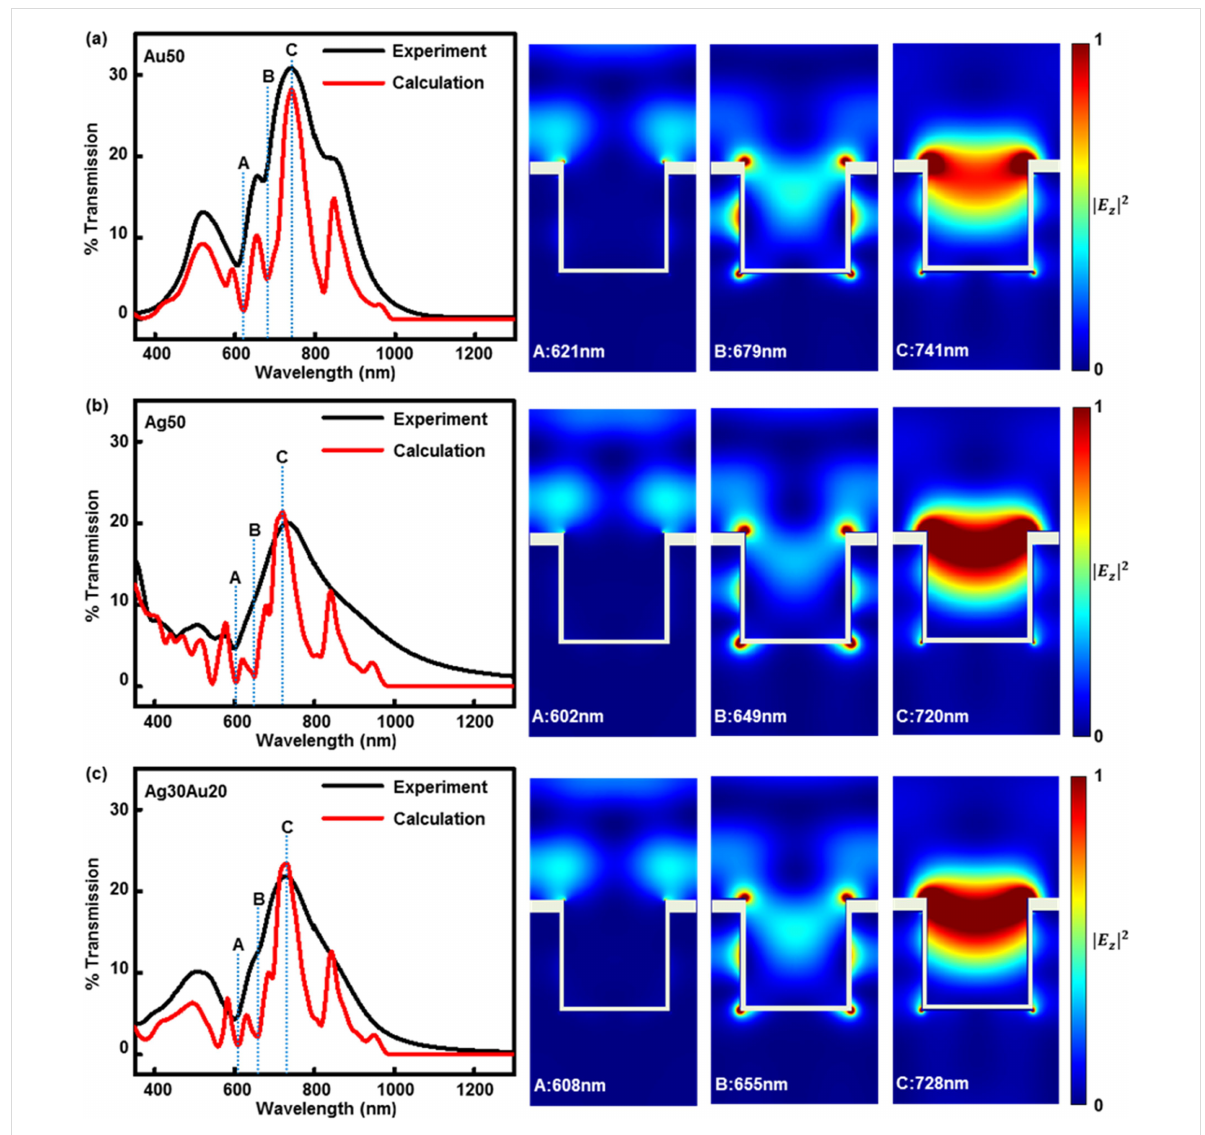
Figure 2: Experimental transmission spectra (black), electrodynamic modeling transmission spectra (red), and 2D calculated electric field plots corre- sponding to wavelengths for peaks labeled as A, B, and C in the transmission plot of (a) Au50, (b) Ag50 and (c) Au20Ag30 full-3D PCs ( ≈ 380 nm hole diameter, ≈ 340 nm relief depth, ≈ 580 nm hole spacing, ≈ 50 nm top metal layer, ≈ 20 nm metal sidewall, and ≈ 15 nm bottom metal layer).